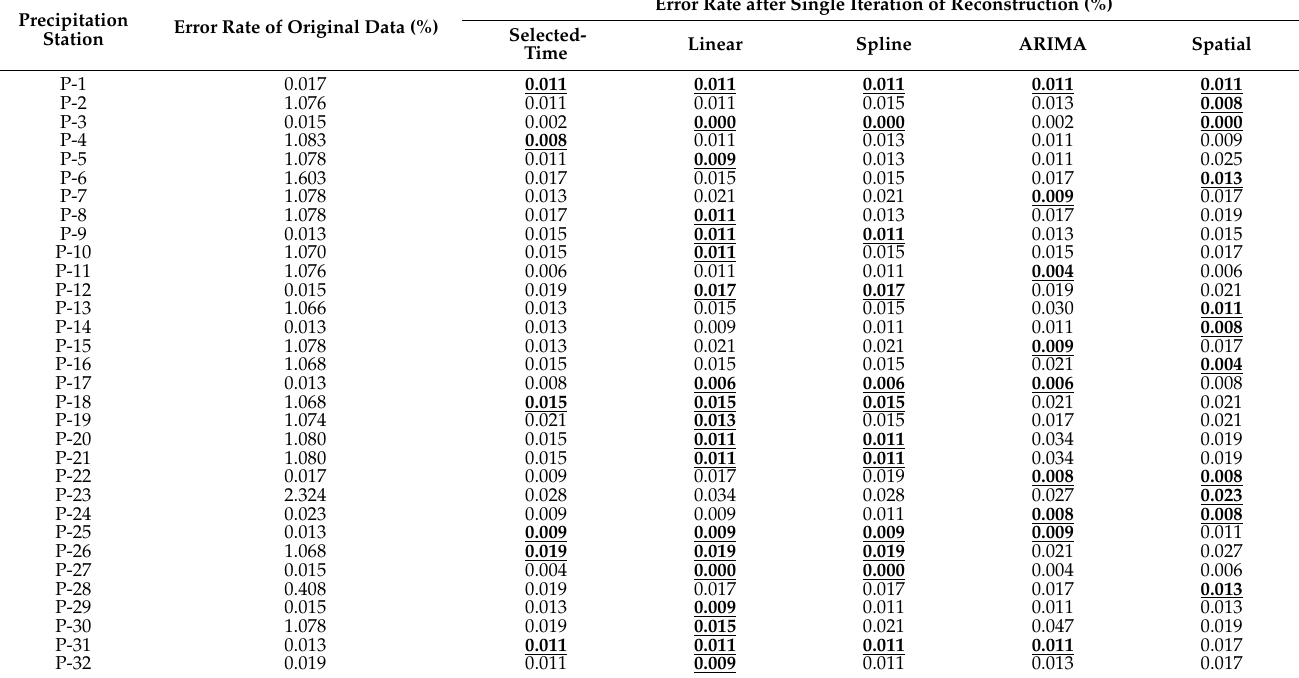
Table 8. Error rate comparison of five reconstruction methods in 32 precipitation